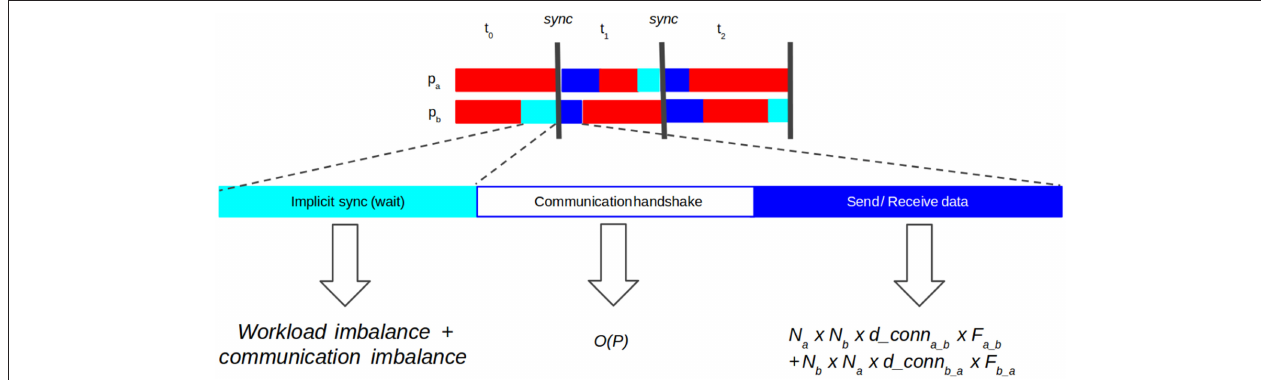
FIGURE 2 | Diagram showing synchronization phases in point-to-point (P2P) communication. Implicit synchronization (light blue): processes waiting for each other to start communication. Communication handshake (white): explicit notification to other processes of the intention to send data (receiver processes must prepare buffers). Send-receive data (dark blue): processes send spiking data to each other. The cost of the send-receive data is determined by the number of neurons on two communicating processes ( N a and N b ), how densely connected those populations are ( d _ conn a _ b and d _ conn b _ a ) and the frequency at which those populations communicate ( F a b and F b a